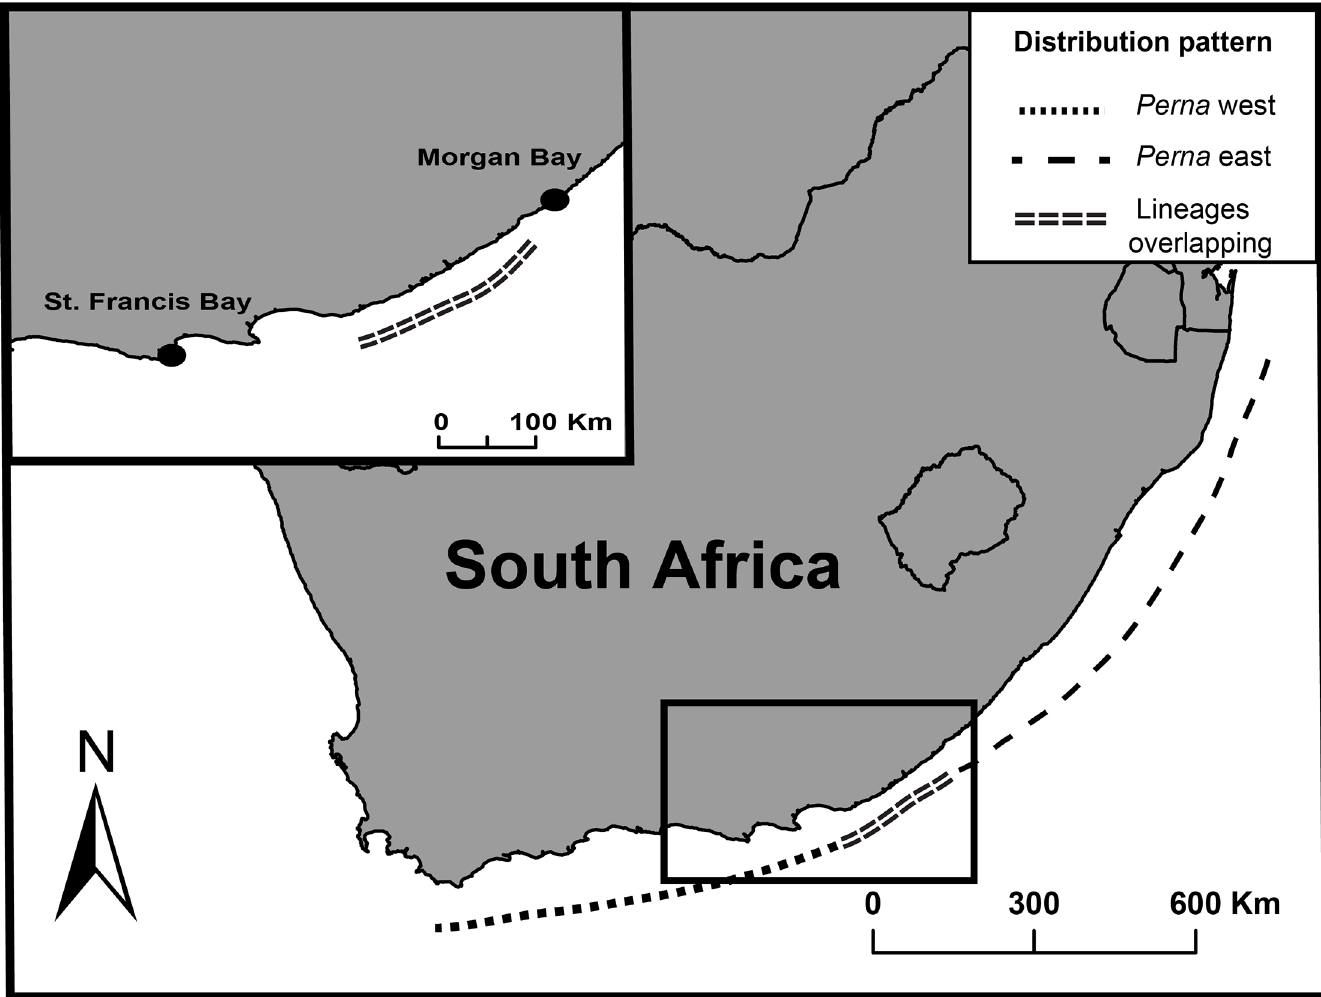
Fig 1. Field sites for Perna east (St. Francis Bay) and Perna west (Morgan Bay) and the geographic distributions of the two genetic lineages. Note that the study sites fall outside the area of lineage overlap.